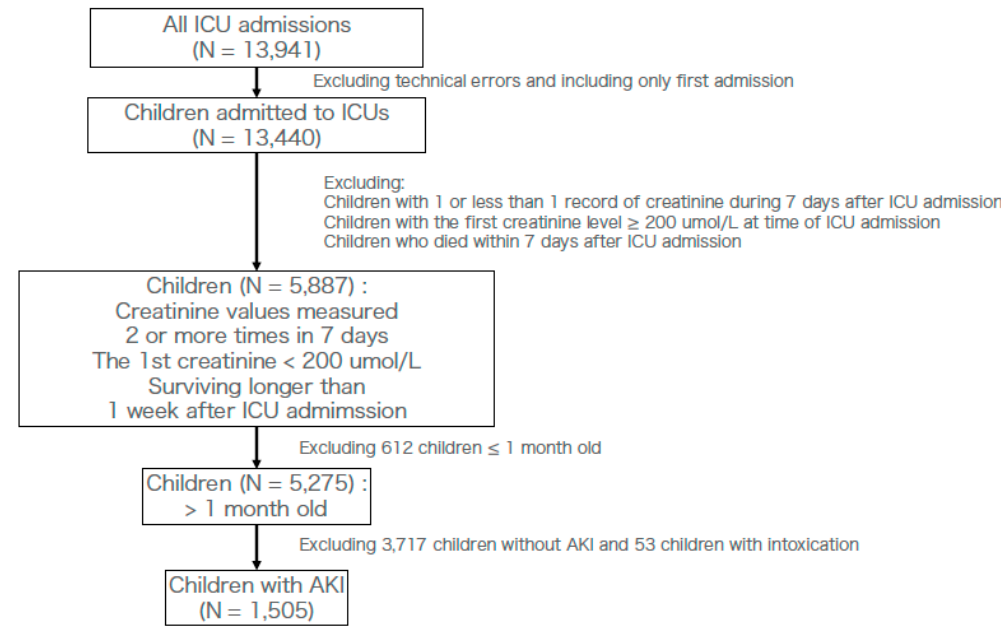
Figure 1. Flow chart of ICU admissions for this observational study. AKI; acute kidney injury. ICU; intensive care unit.